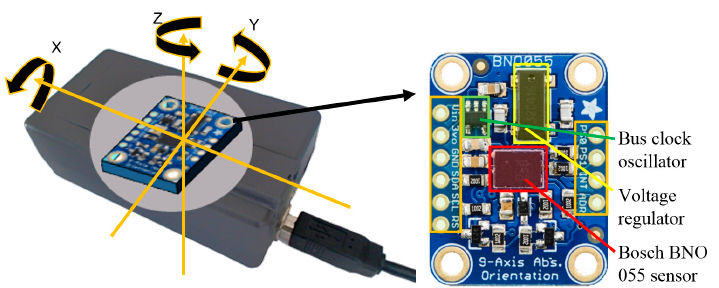
Figure 1. Designed head movement tracking device (left) and the BNO 055 on an Adafruit™ breakout board.